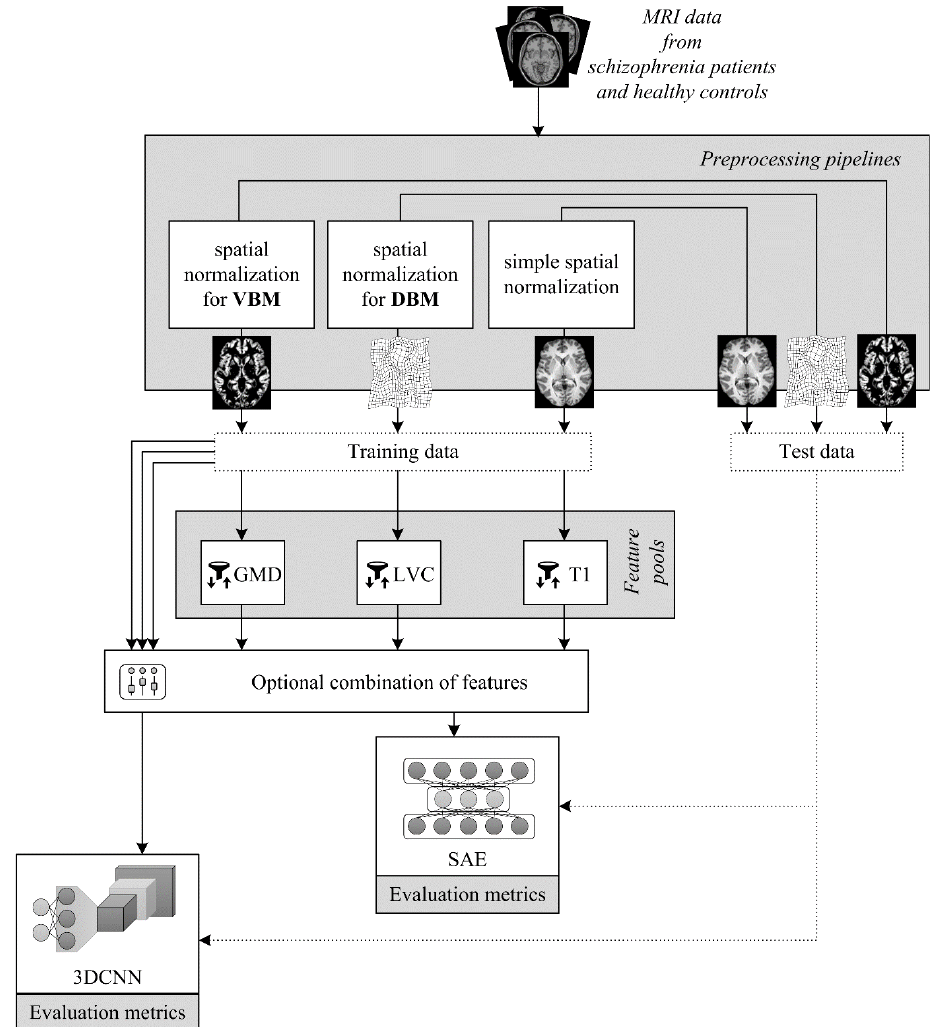
Figure 1. Scheme of the performed experiments with SAE-based and 3D CNN-based classifiers trained on different types of brain imaging features. There are three distinct features extracted using different image preprocessing pipelines – two complex pipelines taken from automated morphometry methods (VBM, DBM) and a simple one that includes only registration and skull-stripping operations. The features are pooled using univariate testing, sorting, and thresholding in the case of the SAE classifier, whereas all features are taken in with the 3D CNN classifier. The experiments further involve changes in the architectures and the optional combination of different feature types.